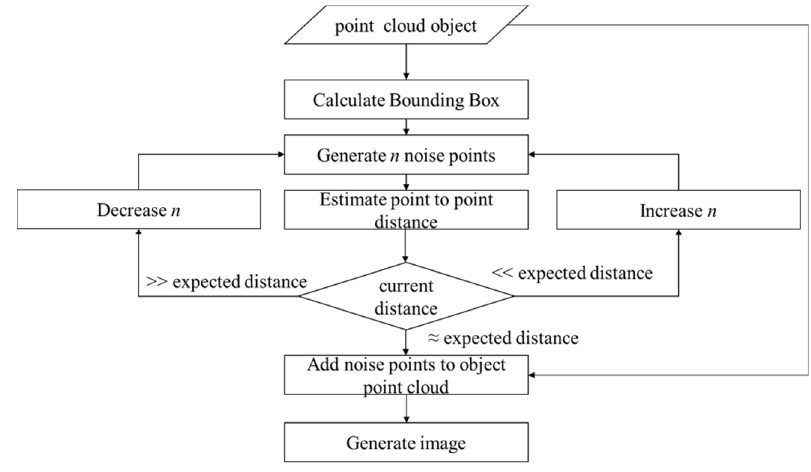
Figure 3. Generation and addition of noise points to point cloud objects.